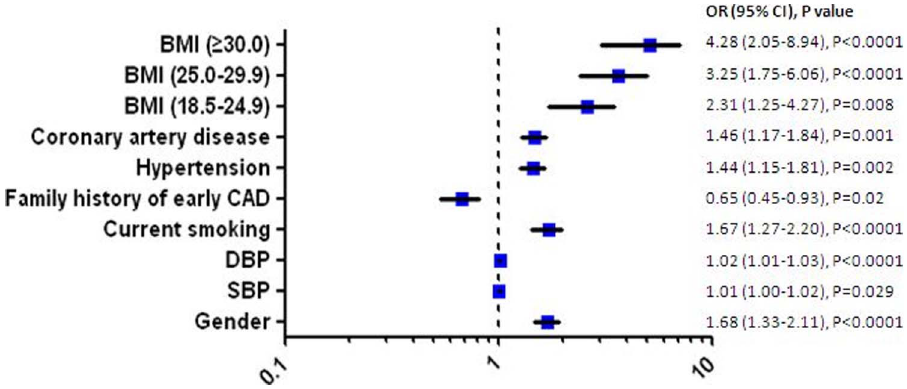
Figure 2. Independent predictors of failure to reach recommended LDL-Cholesterol targets.